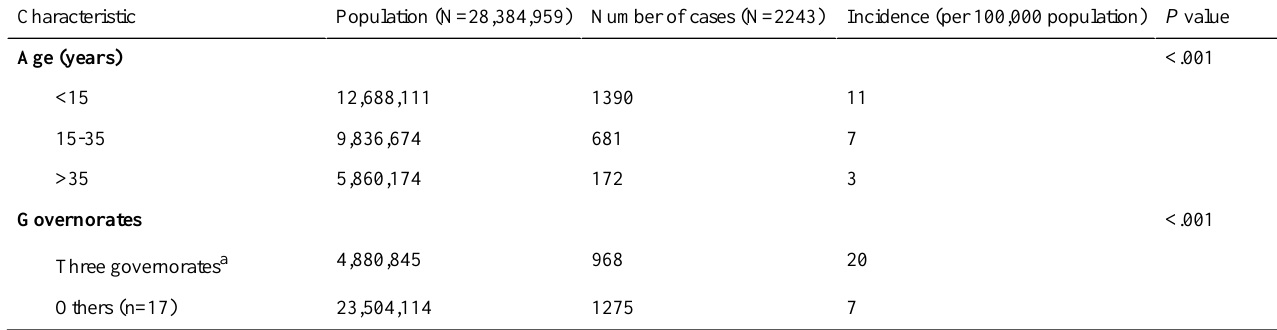
Table 1. Diphtheria incidence by age and governorate in Yemen from 2017 to